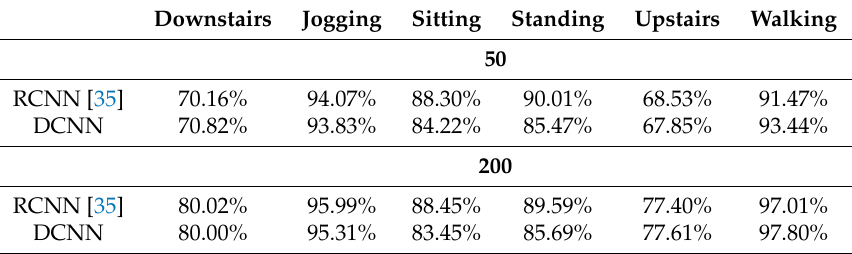
Table A3. Average f1-scores of the 10-fold cross-validation of the WISDM